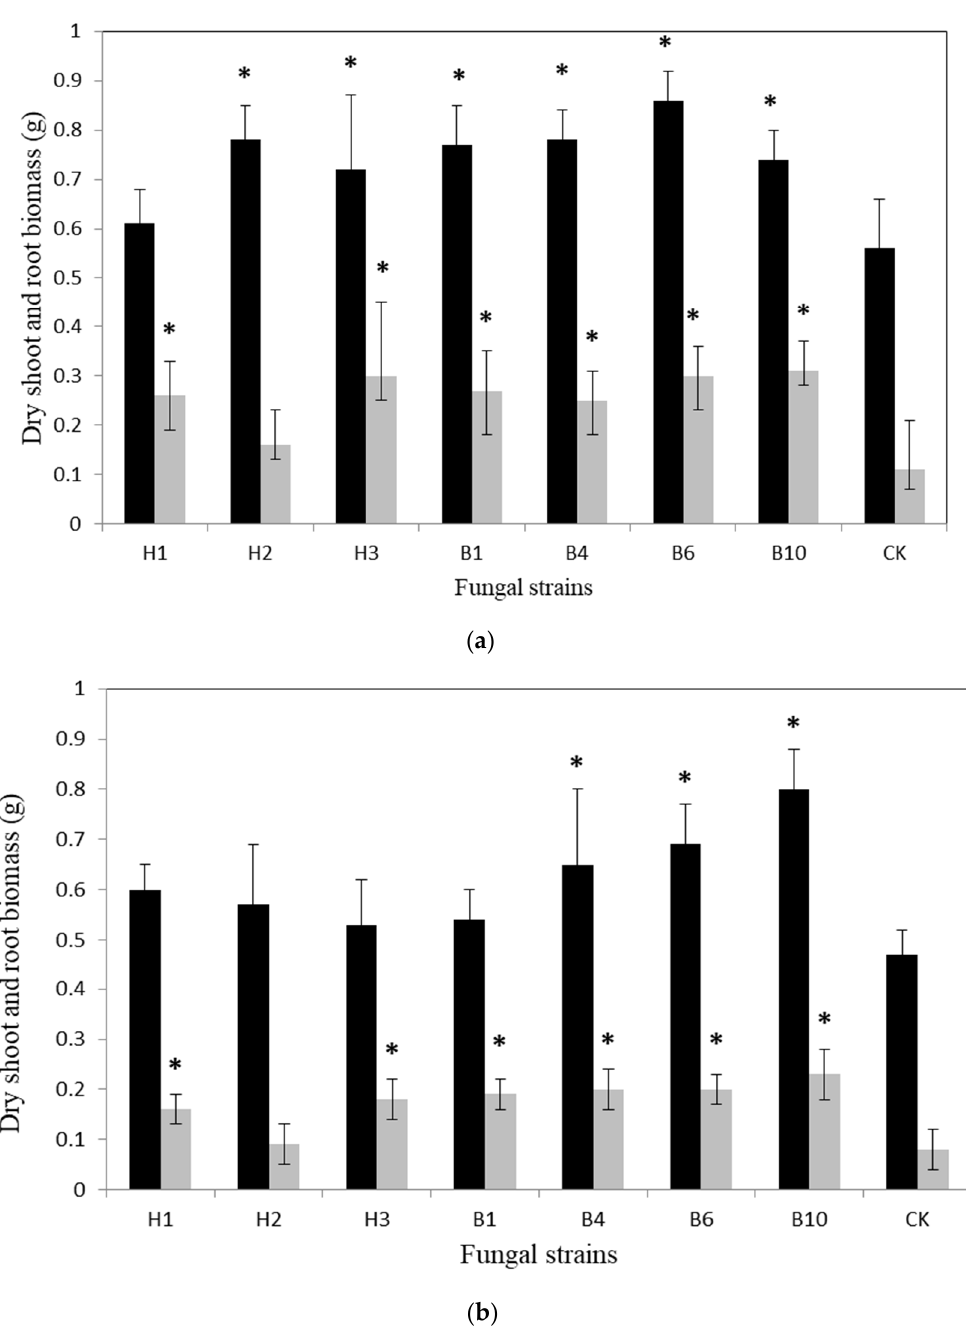
Figure 2. Experiment with various fungal isolates: Growth response of ( a ) Brassica rapa and ( b ) Lactuca sativa in a pot. Black and grey bars show shoot and root biomass, respectively. The error bars show standard deviations between replicates ( n = 5), where * indicates the statistical significance of the treatment when compared with the control (CK) using Dunnett’s test ( p < 0.05).